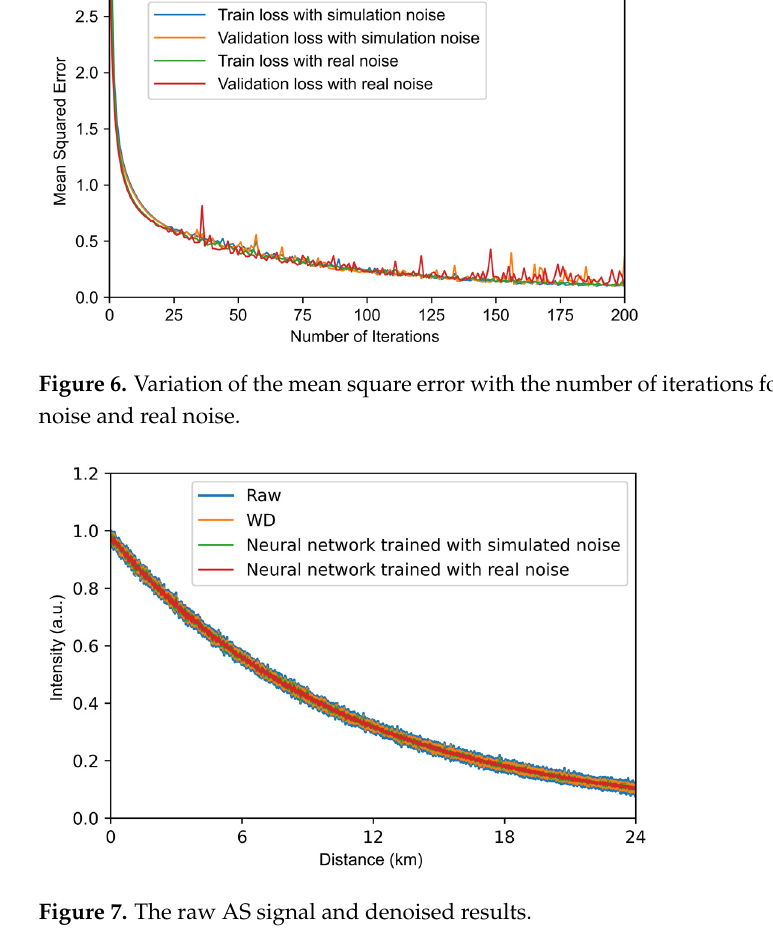
Figure 6. Variation of the mean square error with the number of iterations for training with simu- lated noise and real noise.